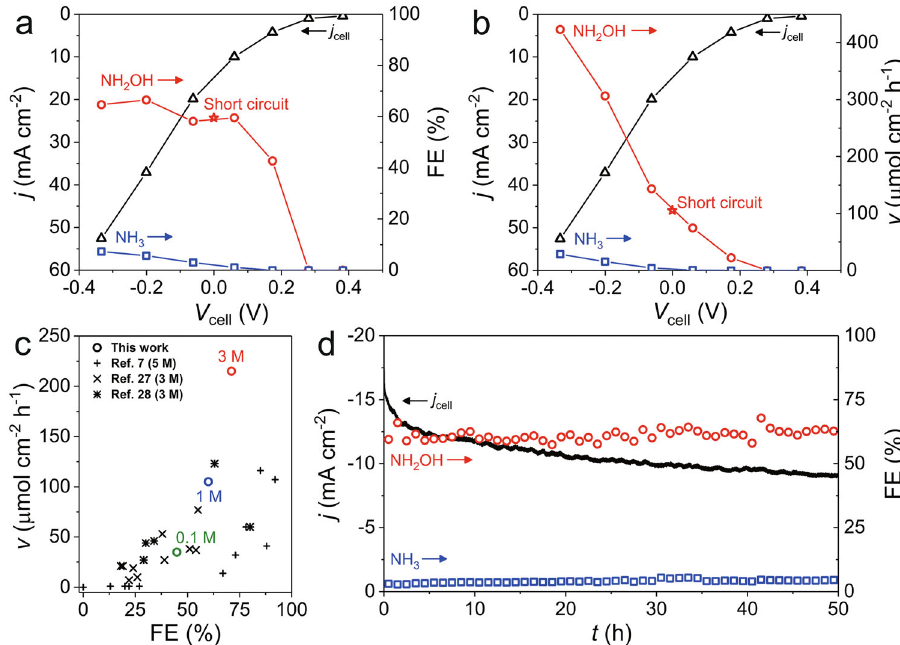
Fig. 4 NH 2 OH production in a fl ow-type H 2 – NO fuel cell. a FE and b production rate ( v ) of NH 2 OH and NH 3 at various cell voltages: (conditions) an Ar- saturated 1 M HClO 4 electrolyte, Pt anode, FeNC-dry-0.5 cathode. The fuel cell operation was performed for 1 h at a constant cathode potential, screened from 0.4 to − 0.2 V RHE with a 0.1 V potential step. c Comparison of NH 2 OH production rate and FE NH2OH for various catalysts recorded in H 2 – NO fuel cells at short-circuit conditions. The electrolyte used for each measurement was indicated in the fi gure. d Current density and FEs during a 50 h long-term durability test at a short-circuit